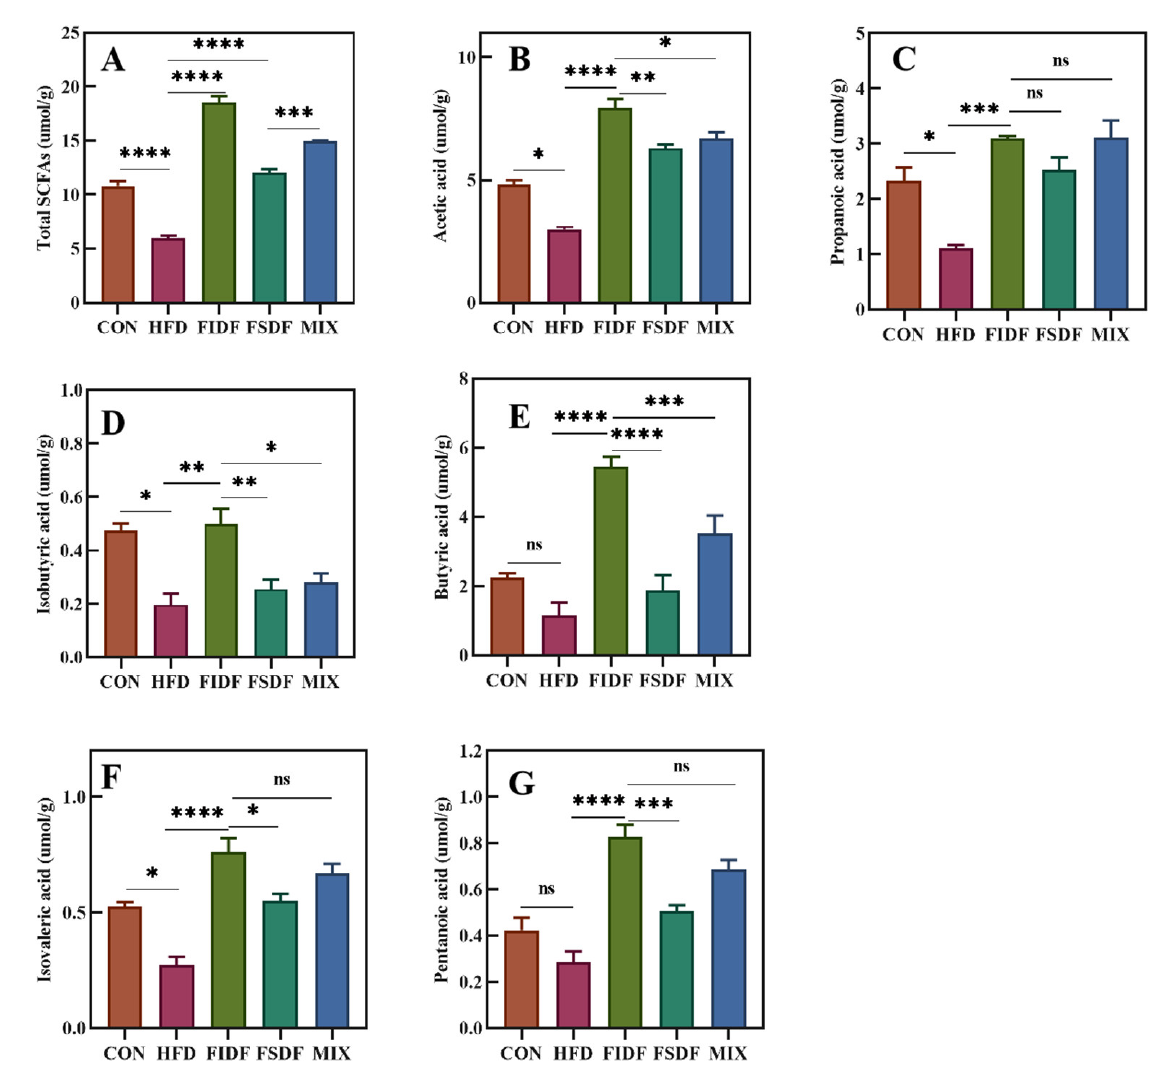
Figure 7. Effects of FIDF and FSDF on SCFA production. Concentrations of ( A ) total SCFAs, ( B ) acetic acid, ( C ) propanoic acid, ( D ) isobutyric acid, ( E ) butyric acid, ( F ) isovaleric acid, and ( G ) pen- tanoic acid. CON, control group; HFD, high-fat diet group; FIDF, group supplemented with FIDF alone; FSDF, group supplemented with FSDF alone; MIX, group supplemented with FIDF and FSDF together. Data are expressed as mean ± SEM ( n = 6). * p < 0.05; ** p < 0.01; *** p < 0.0001; **** p < 0.0001; ns, not significant.